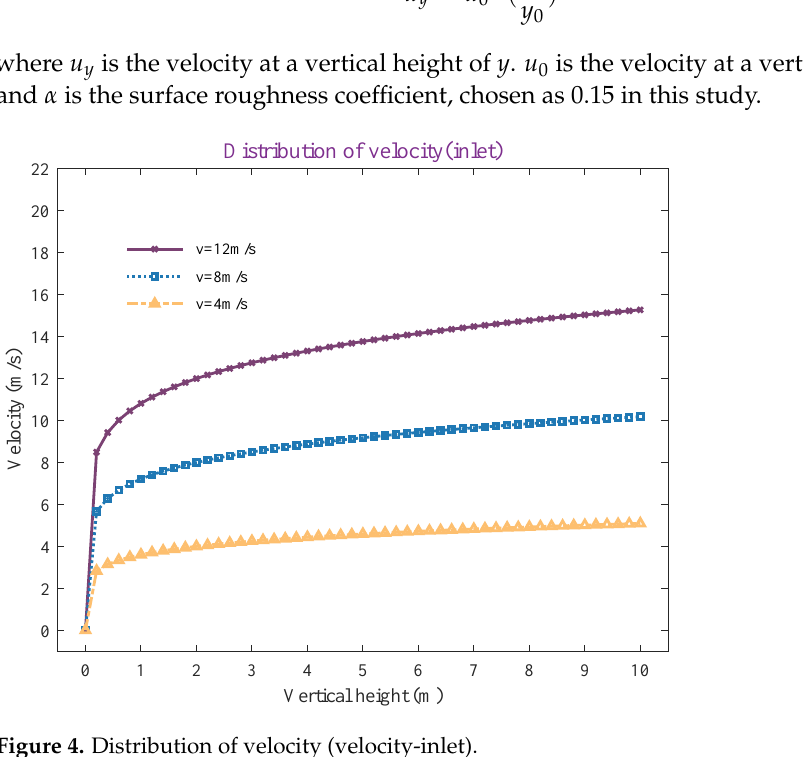
Figure 4. Distribution of velocity